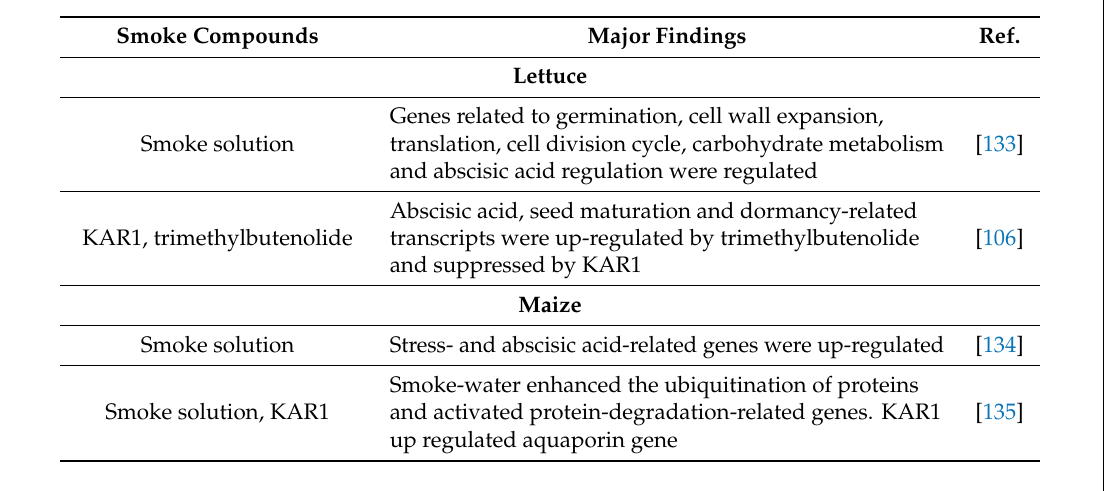
Table 4. Summary of molecular analyses of various plants exposed to karrikins / butenolides and plant-derived